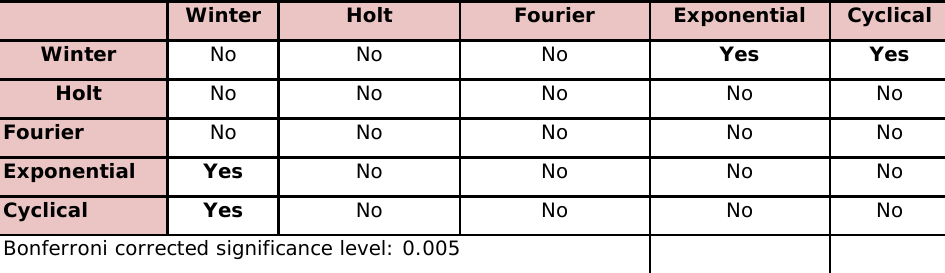
Table 9. “Significant differences for forecasting